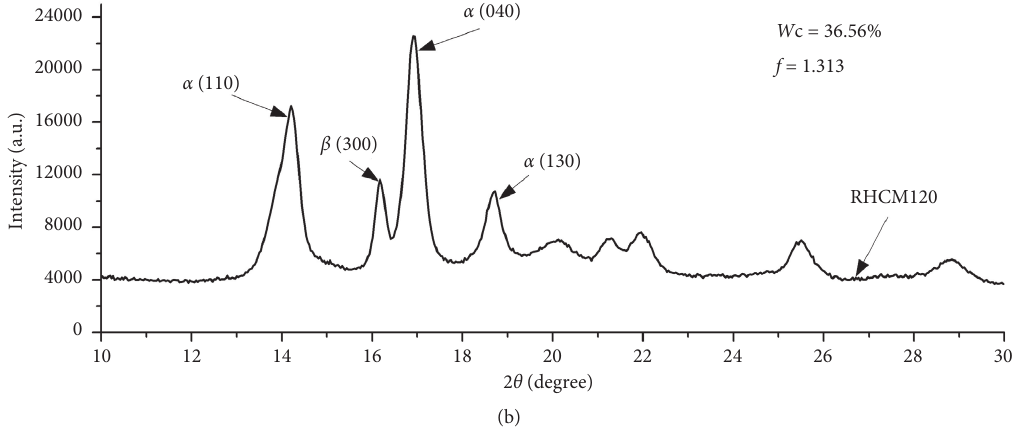
Figure 15: X-ray diffraction curves of (a) RHCM90 and (b)